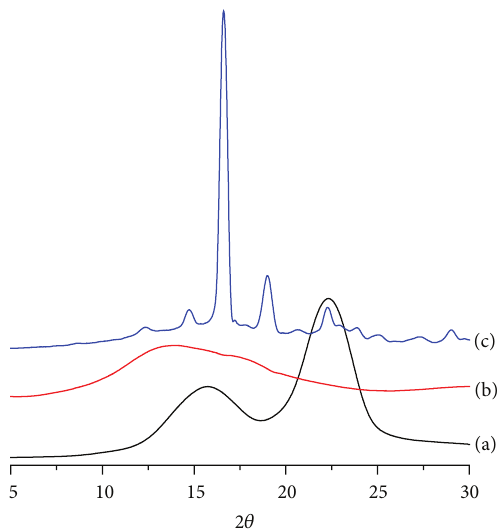
Figure 3: XRD patterns of (a) cellulose, (b) PLA, and (c) PLA crystalline cellulose biocomposite.